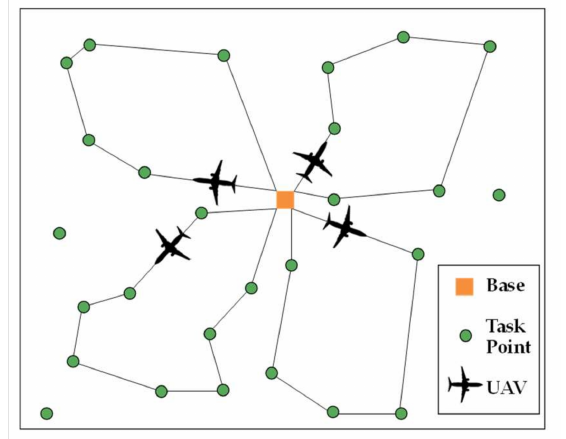
Figure 1. Environmental